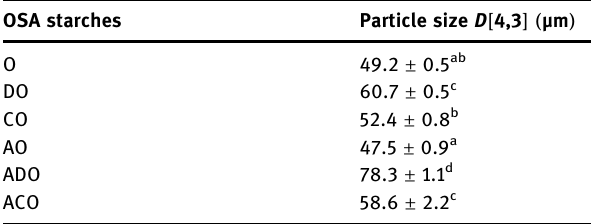
Table 4: Particle sizes ( D [ 4,3 ]) of OSA starches OSA